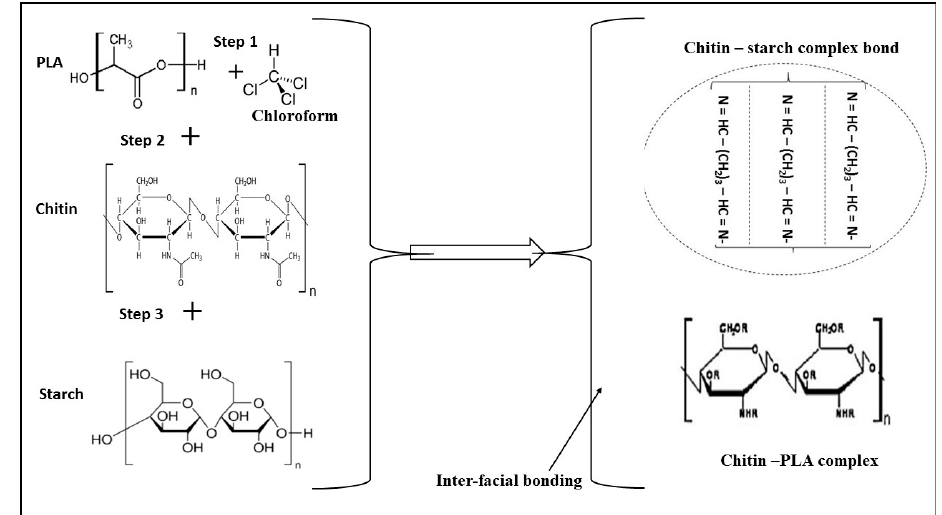
Figure 6. Picture representation of the interfacial bonding between polylactic acid (PLA)–chitin and chitin–starch.